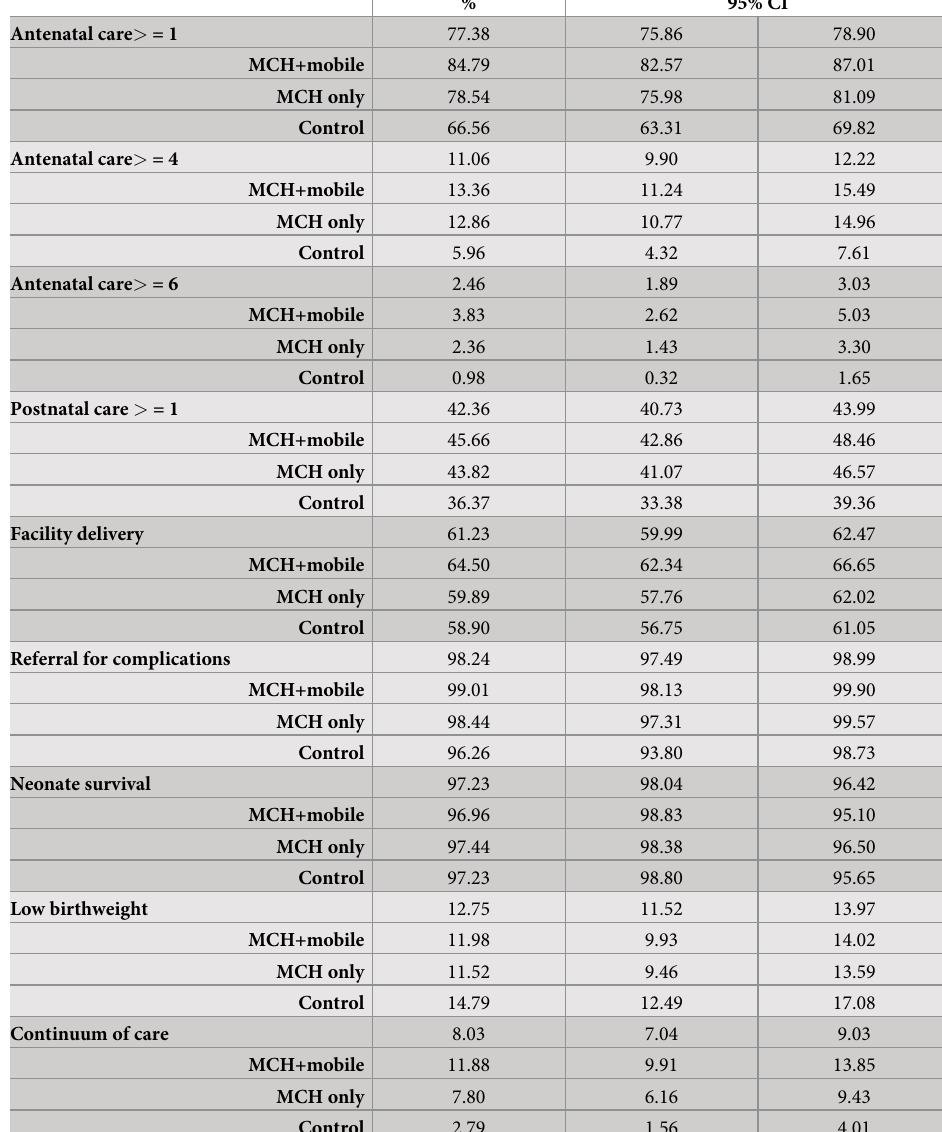
Table 4. The expected outcomes as predicted by multivariate analysis